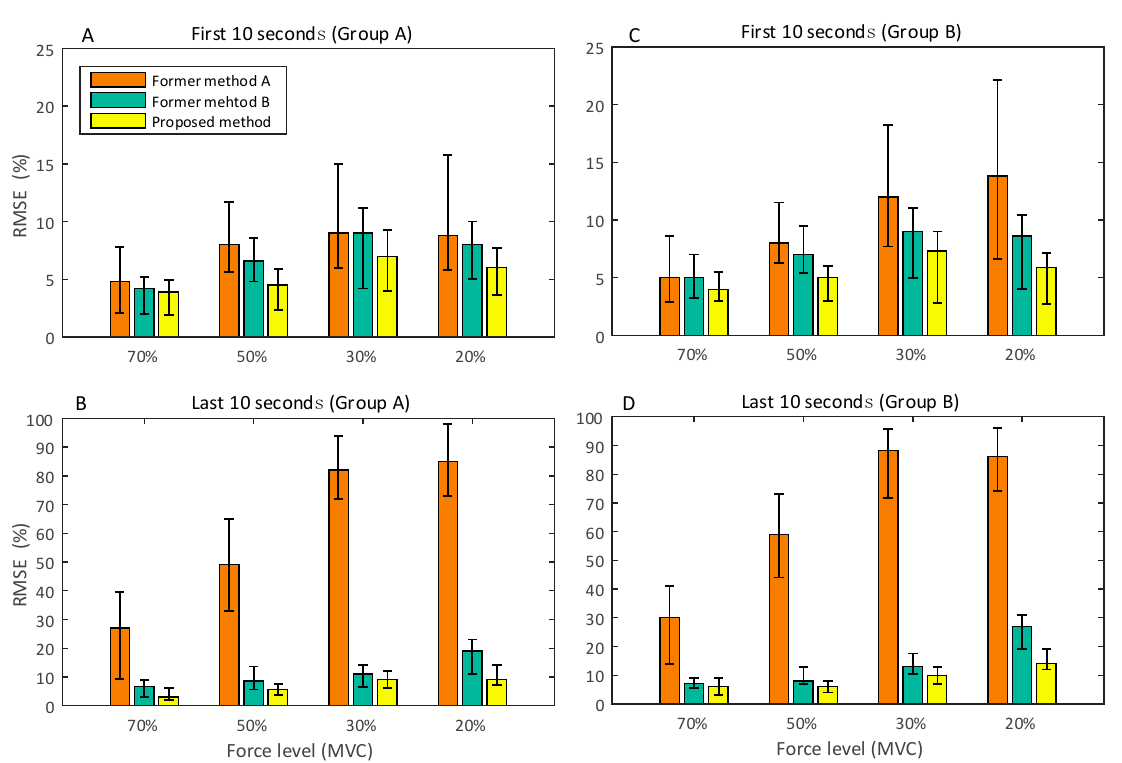
Figure 10. Results of the static validation tasks.